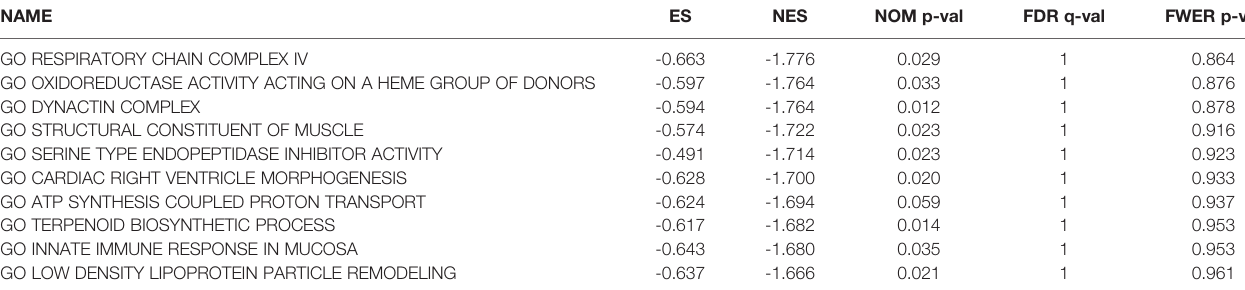
TABLE 1 | GO enrichment analysis (Top